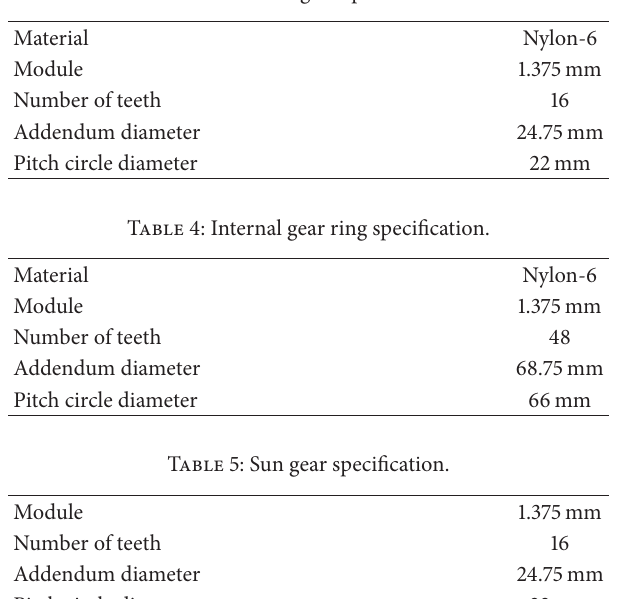
Table 3: Planet gear specification.